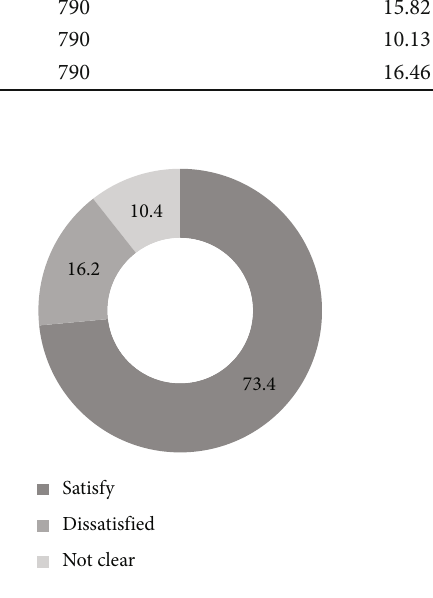
Figure 1: The satisfaction of teachers in innovation and entrepreneurship